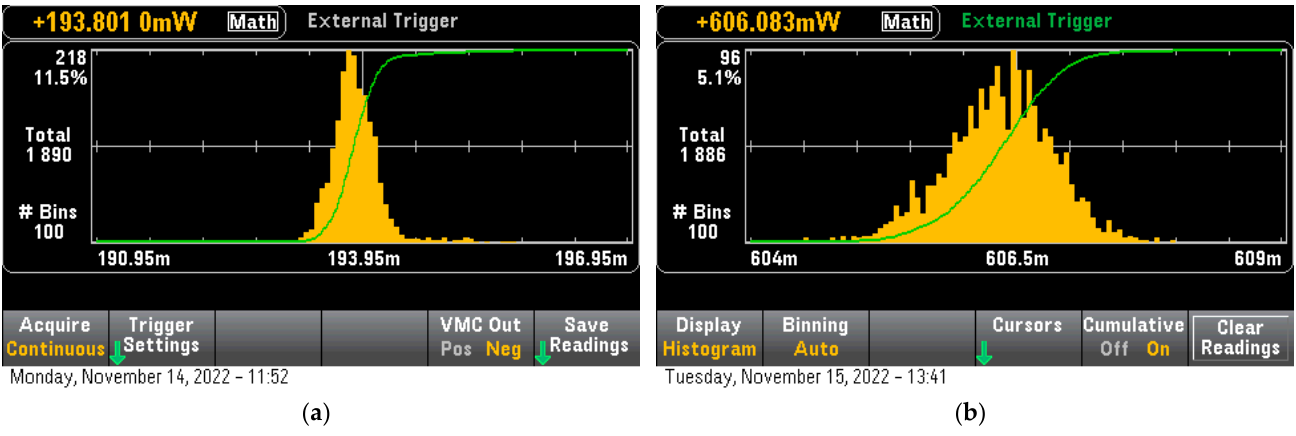
Figure 7. Uncompressed Lenet-5 Model Inference consumption ( a ) For ESP32, ( b ) For STM32H7. On the compressed LeNet-5 on STM32H7 the total time per inference was found to